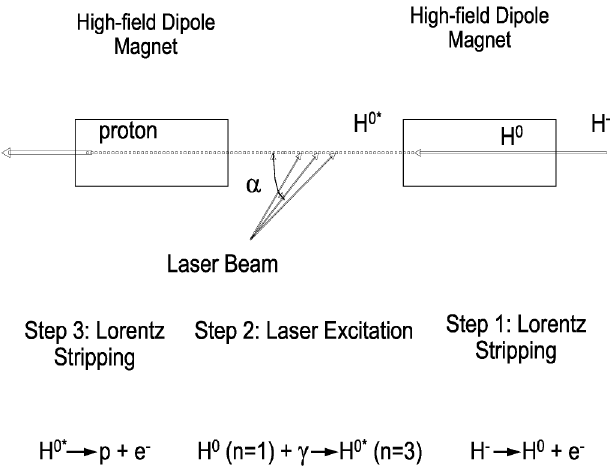
FIG. 1. General scheme of frequency sweep